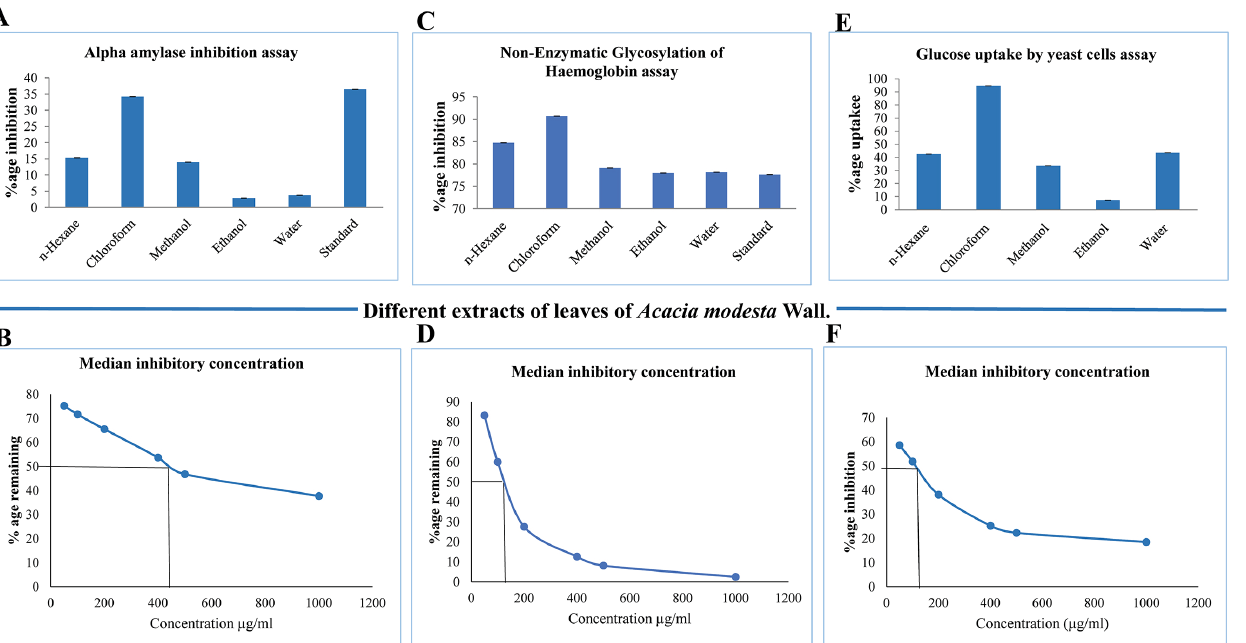
FIGURE 1 - Anti-diabetic Activity of Extracts of leaves of Acacia modesta Wall. A) Alpha amylase inhibition assay B) Dose response relationship of chloroform extract using alpha amylase inhibition assay C) Non-enzymatic glycosylation of hemoglobin assay D) Dose response relationship of chloroform extract using non-enzymatic glycosylation of hemoglobin assay E) Glucose uptake by yeast cells assay F) Dose response relationship of chloroform extract using glucose uptake by yeast cells